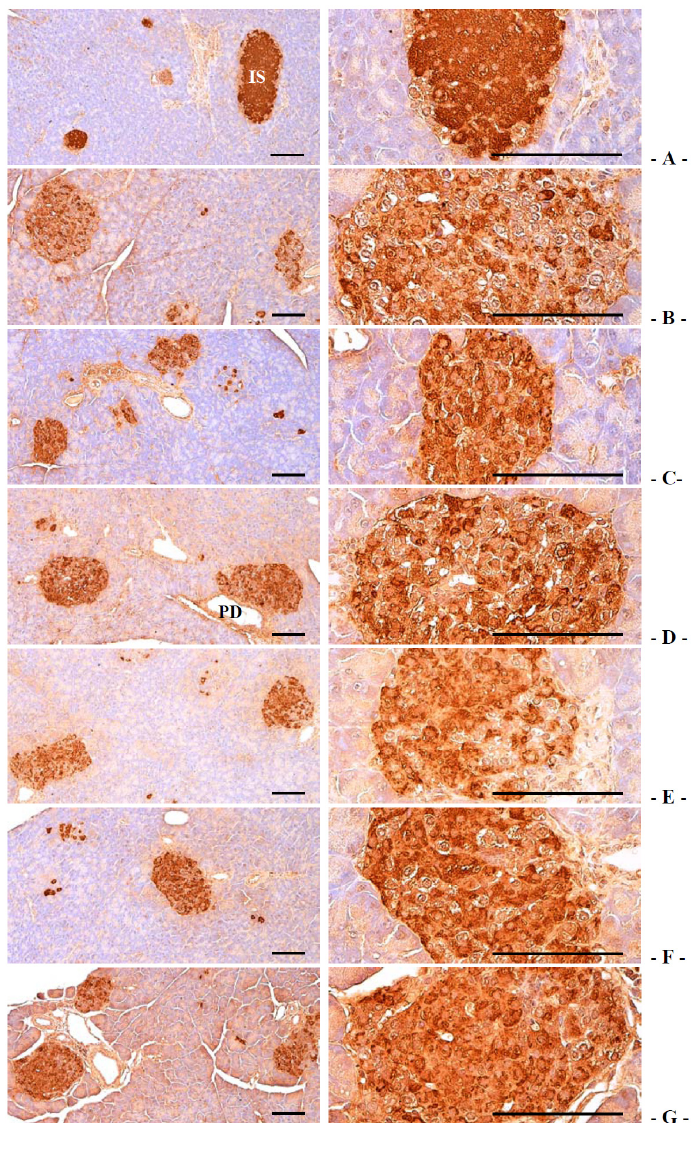
Figure 5. Representative histological images of the insulin-immunoreactive cells in the pancreas, taken from intact normoglycemic or db/db mice. ( A ) Intact control mouse; ( B ) db control mouse; ( C ) metformin 250 mg/kg treated db mouse; ( D ) GT 400 mg/kg treated db mouse; ( E ) fGT 400 mg/kg treated db mouse; ( F ) fGT 200 mg/kg treated db mouse; ( G ) fGT 100 mg/kg treated db mouse. GT, Green tea aqueous lyophilized extracts; fGT, Aquilariae Lignum-fermented green tea aqueous lyophilized extracts; IS, pancreatic islet; PD, pancreatic secretory duct. All immunostained by avidin-biotin-peroxidase complex. Scale bars = 80